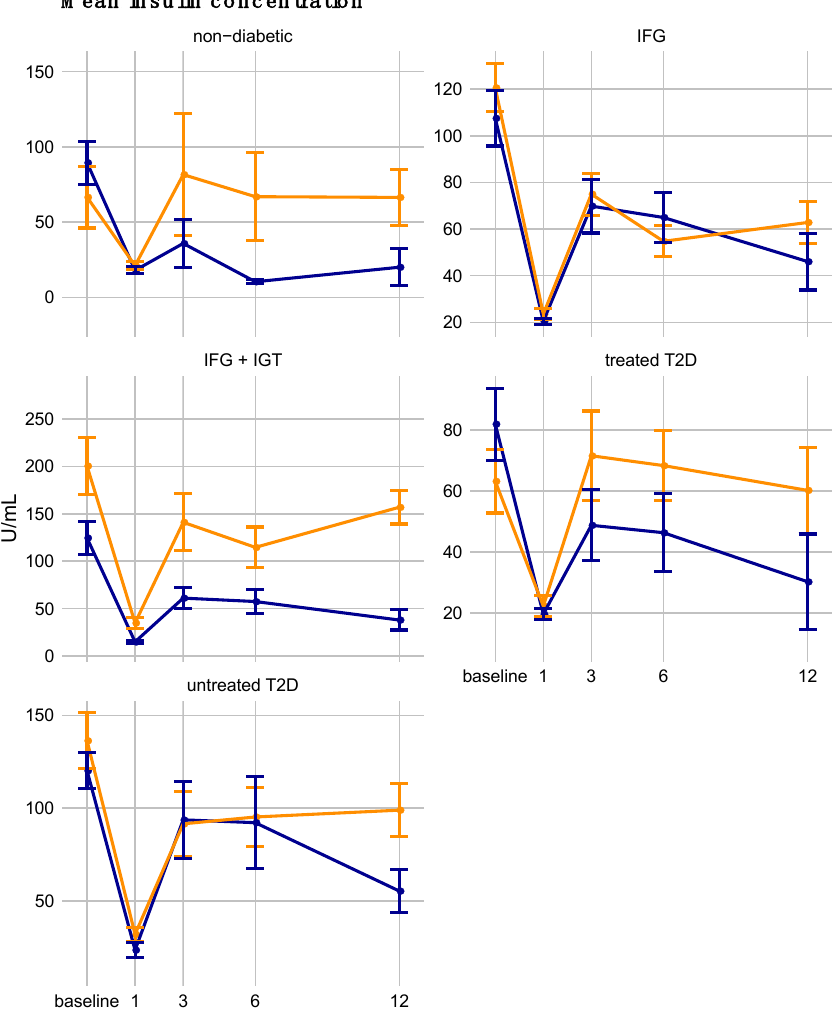
Figure 4. Cross-sectional representation of the sex-divergent long-term responses (i.e., with the largest di ff erence in 12-month scaled responses between men and women) divided by dysglycemia diagnosis from baseline to final follow-up exam. IFG is for impaired fasting glucose, IGT for impaired glucose tolerance, and T2D for type 2 diabetes. Points are model-adjusted means (see Methods). Dashed lines represent quadratic fits. Error bars are for standard errors.